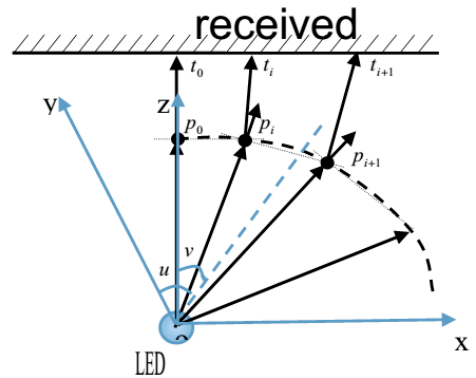
Figure 2. Sketch of generating free-form lens surface. Minerals 2018 , 8 , x FOR PEER REVIEW